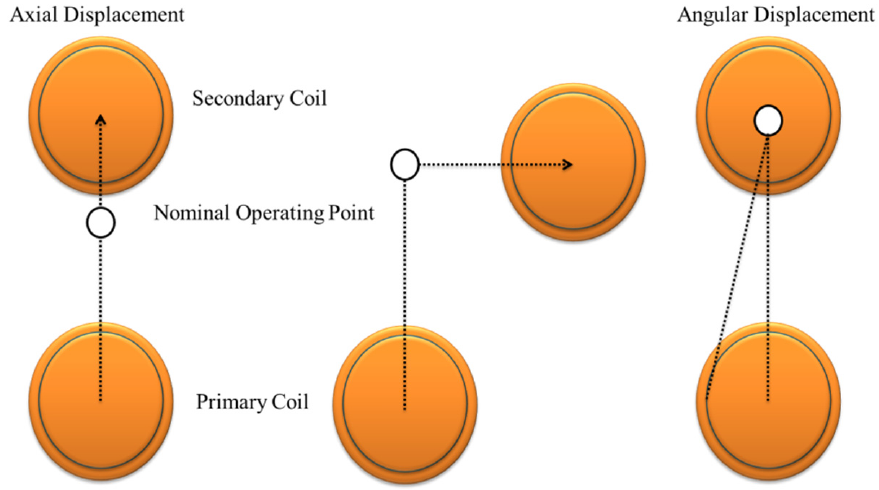
Figure 11. An overview of coil orientation.